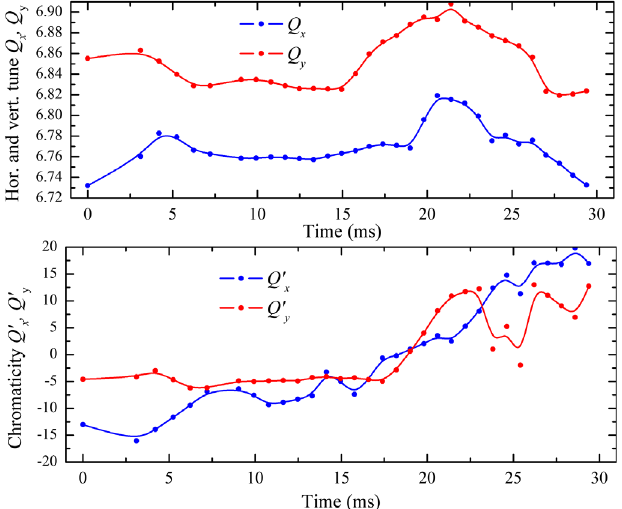
FIG. 3. Measured Booster beam characteristics during the acceleration cycle: (top) the horizontal (blue) and vertical (red) betatron tunes Q x;y ; (bottom) the horizontal (blue) and vertical (red) chromaticities Q 0 x;y .